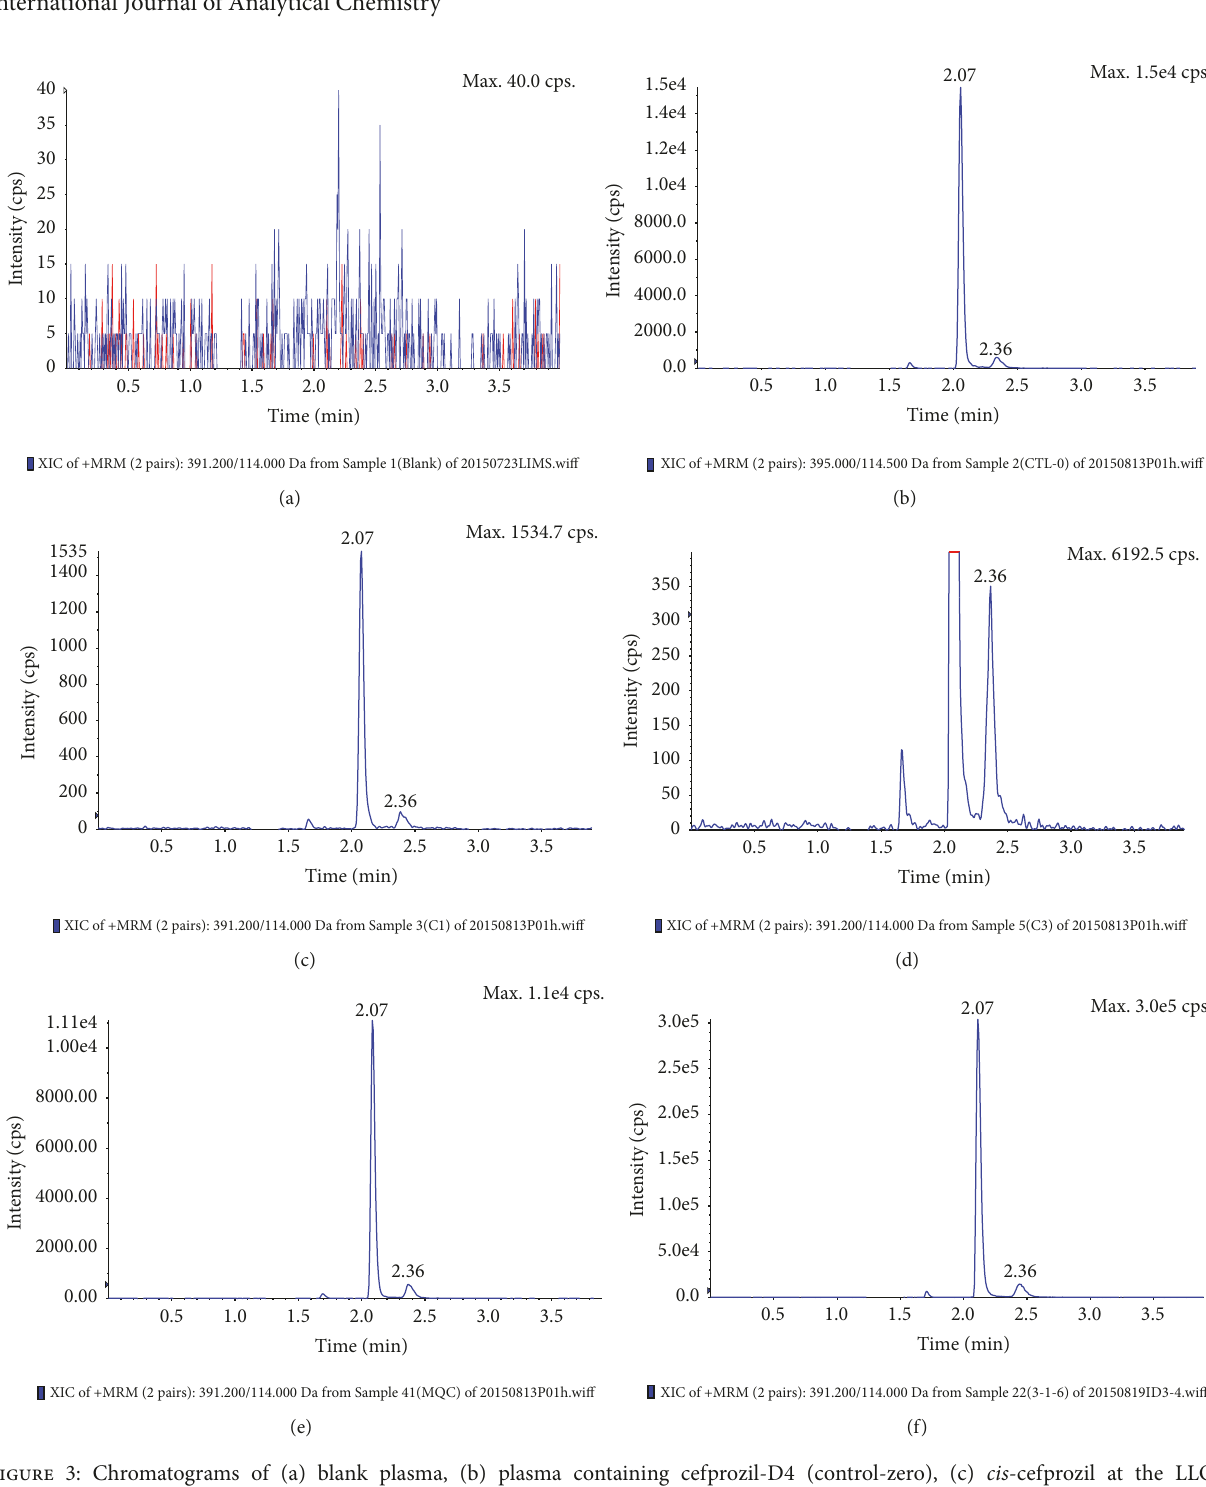
of the spiked mobile phase to calculate matrix effects